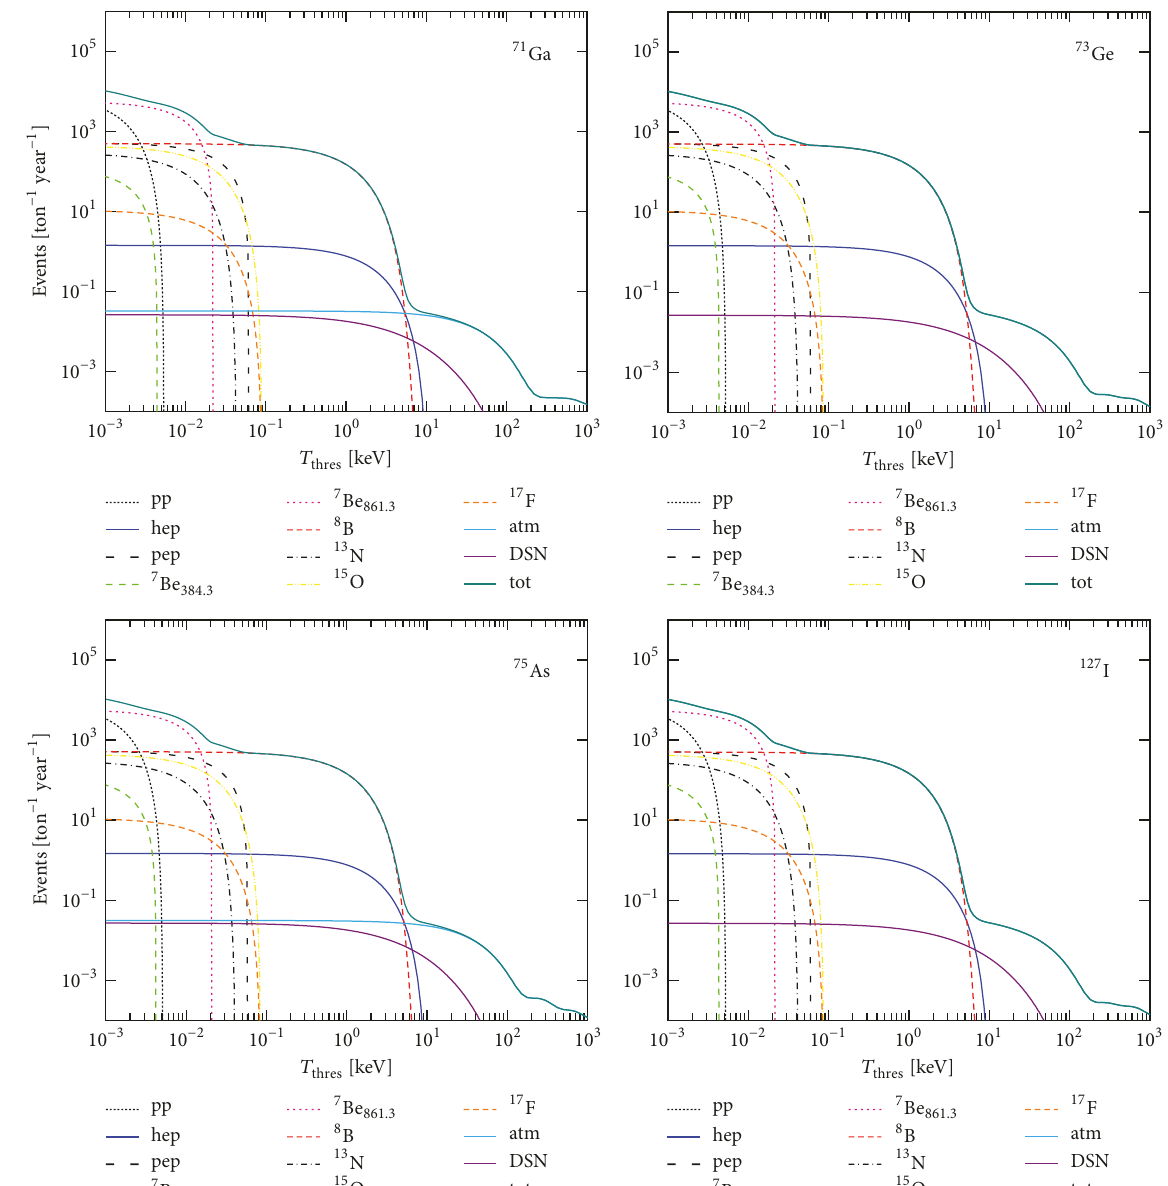
Figure 10: Same as in Figure 9 but for the number of events above the detector